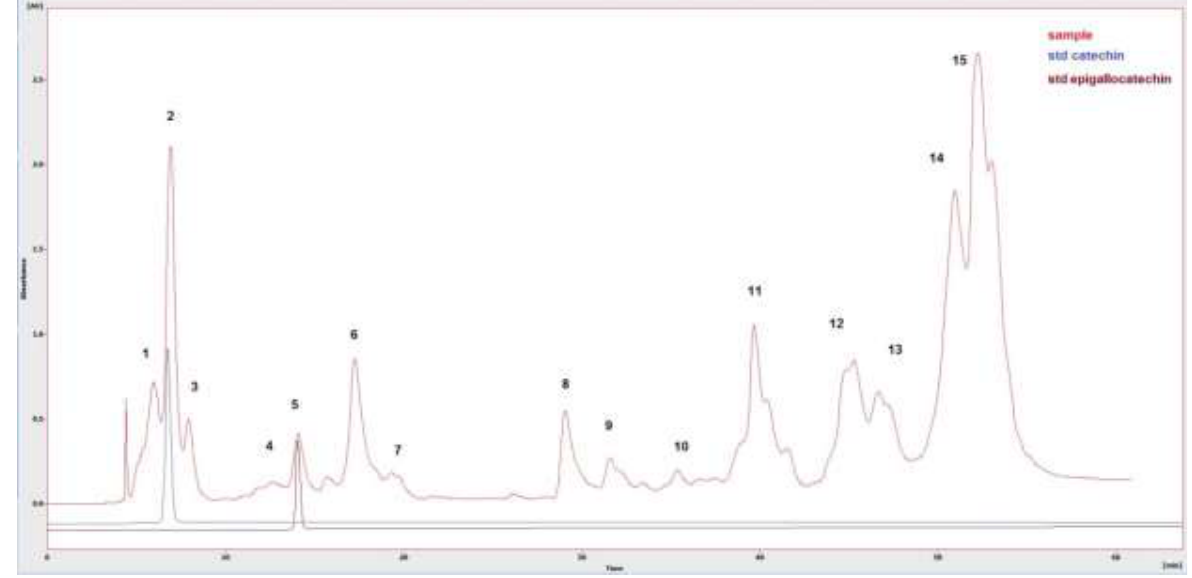
Figure 1. Preparative HPLC Chromatogram For ethyl acetate